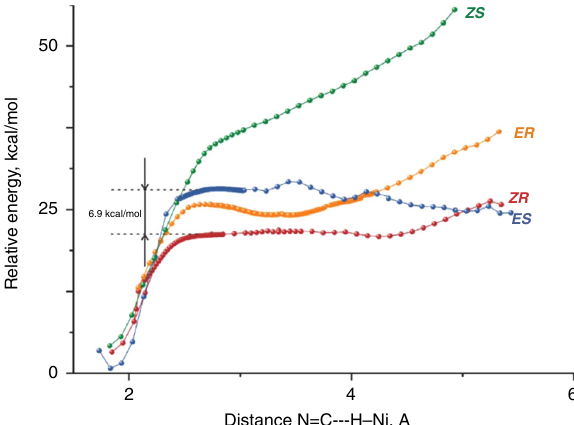
Fig. 6 Energy scans simulating the approach of 1a to the catalytic hydride 12. ZS , ER , ZR , ES : the approach of ( Z )- 1a or ( E )- 1a to the catalyst to form the products ( S )- 2a or ( R )- 2a ,